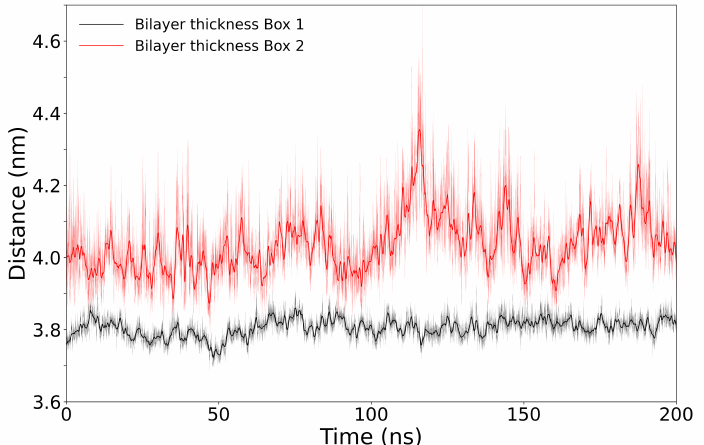
Figure 3. Thickness of the bilayer for Box 1 (thin black line) and Box 2 (thin red line) as a function of time, simulated for 200 ns. Represented by the average distance between the center of mass of the phosphate of each POPC molecule in one layer with respect to the complementary one. Values after a LOWESS smoothing appear in thick black and red lines, respectively.